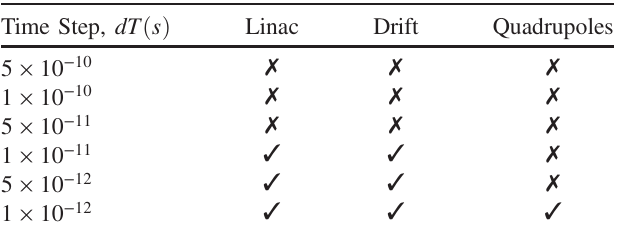
TABLE II. Checkmarks ( ✓ ) indicate desired beam parameters are resolved at that time step. An ( ✗ ) indicates the time step is too large, and results are nonphysical.